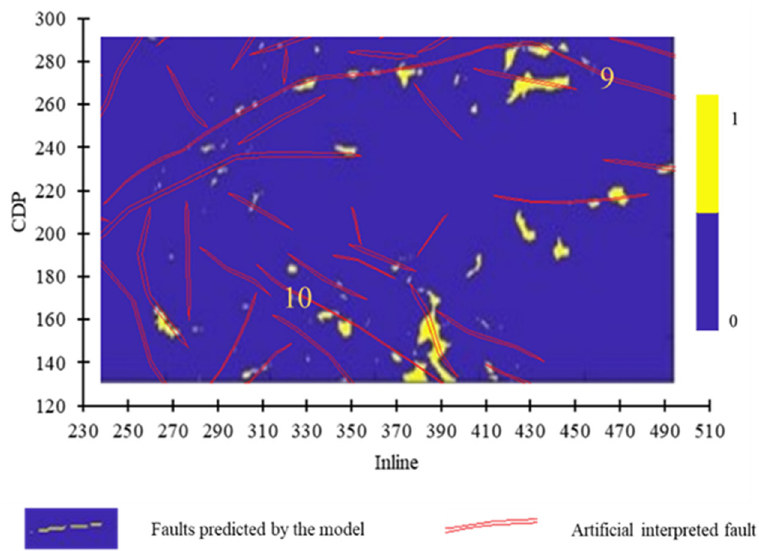
Figure 16. The prediction result of Faults 9–10 by Region A as a training set.